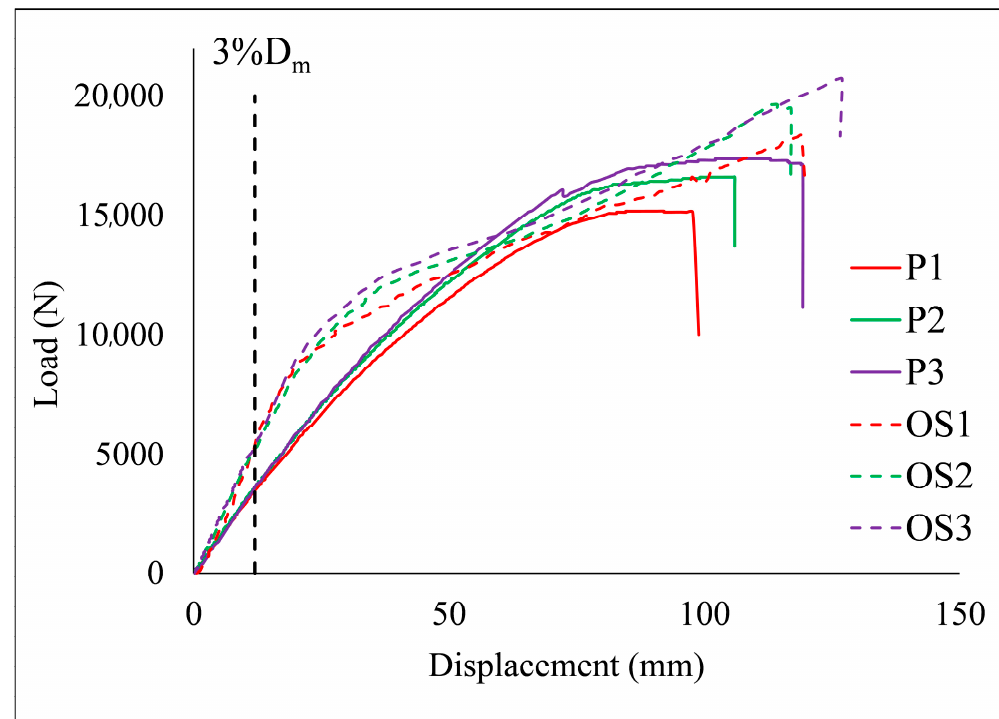
Figure 8. Load-displacement response of DN400 pipes obtained by the plain type (P1, P2, and P3) and the outer stiffened type (OS1, OS2, and OS3), respectively.